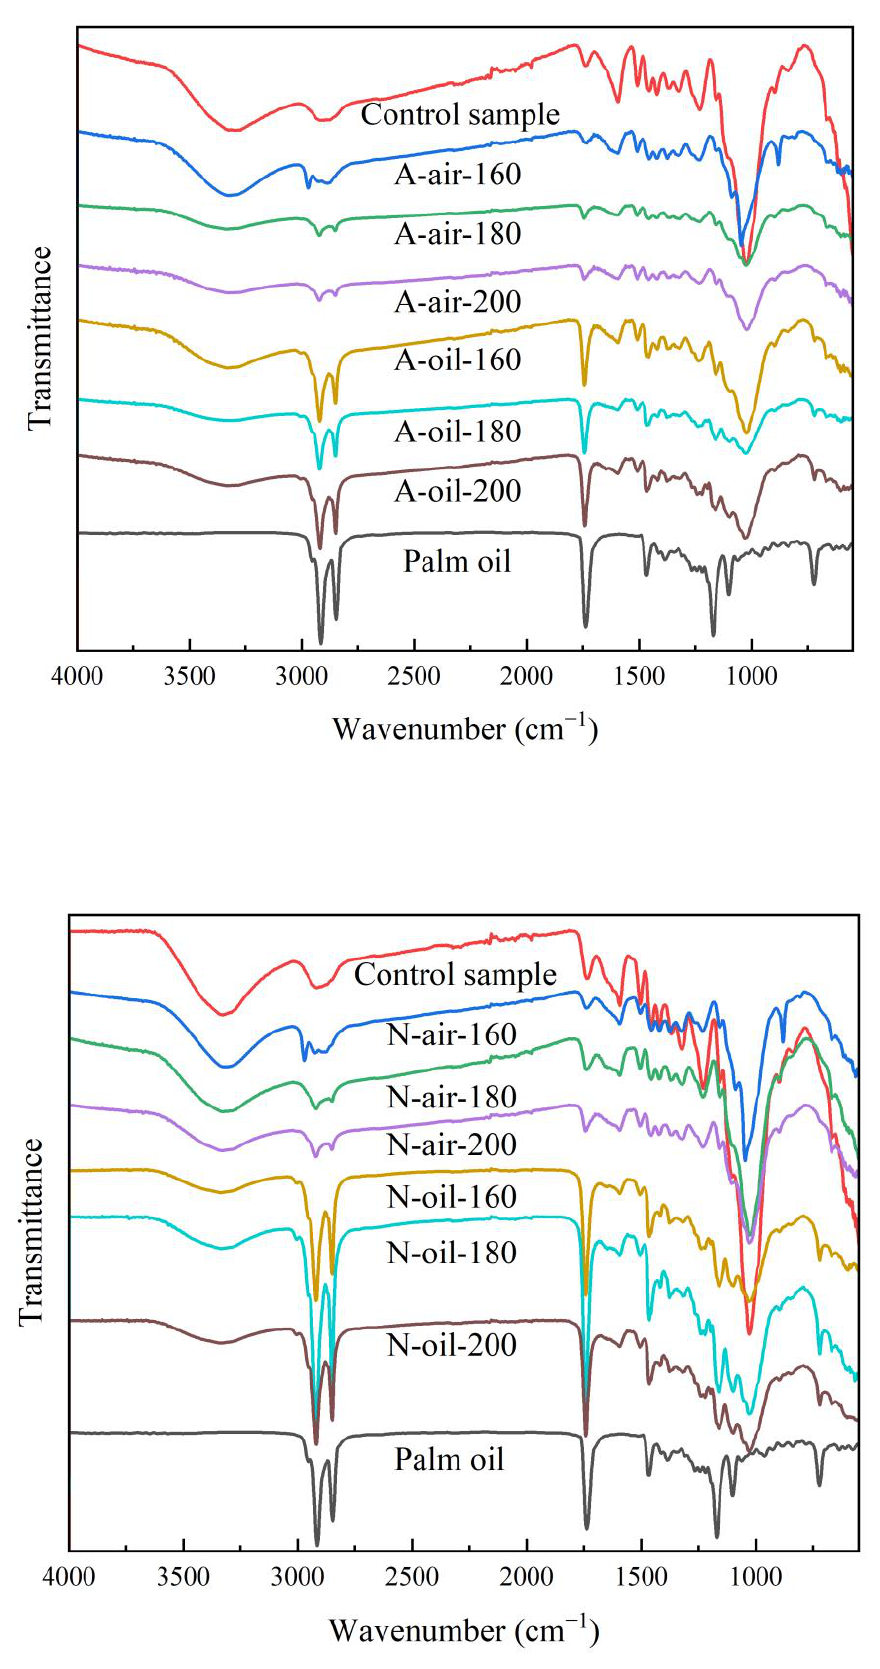
Figure 8. FTIR spectra of Newtonia and Afrormosia heat-treated under air or palm oil .